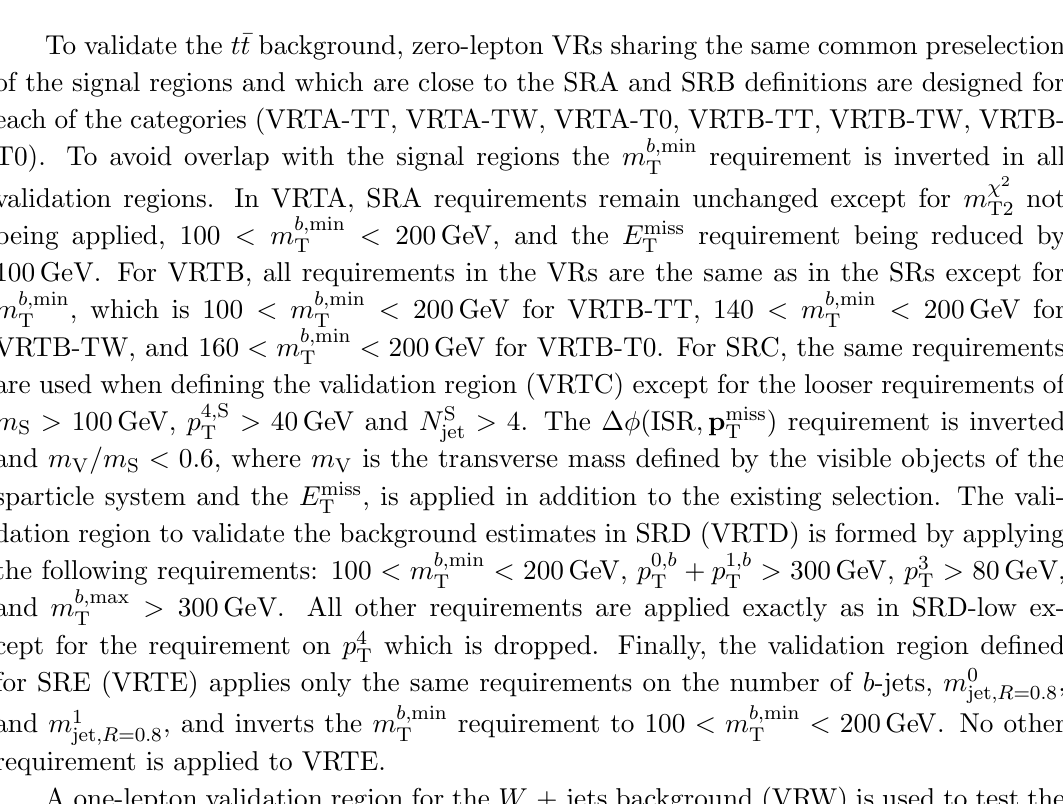
Table 8. Selection criteria for the Z validation regions used to validate the Z background estimates in the signal